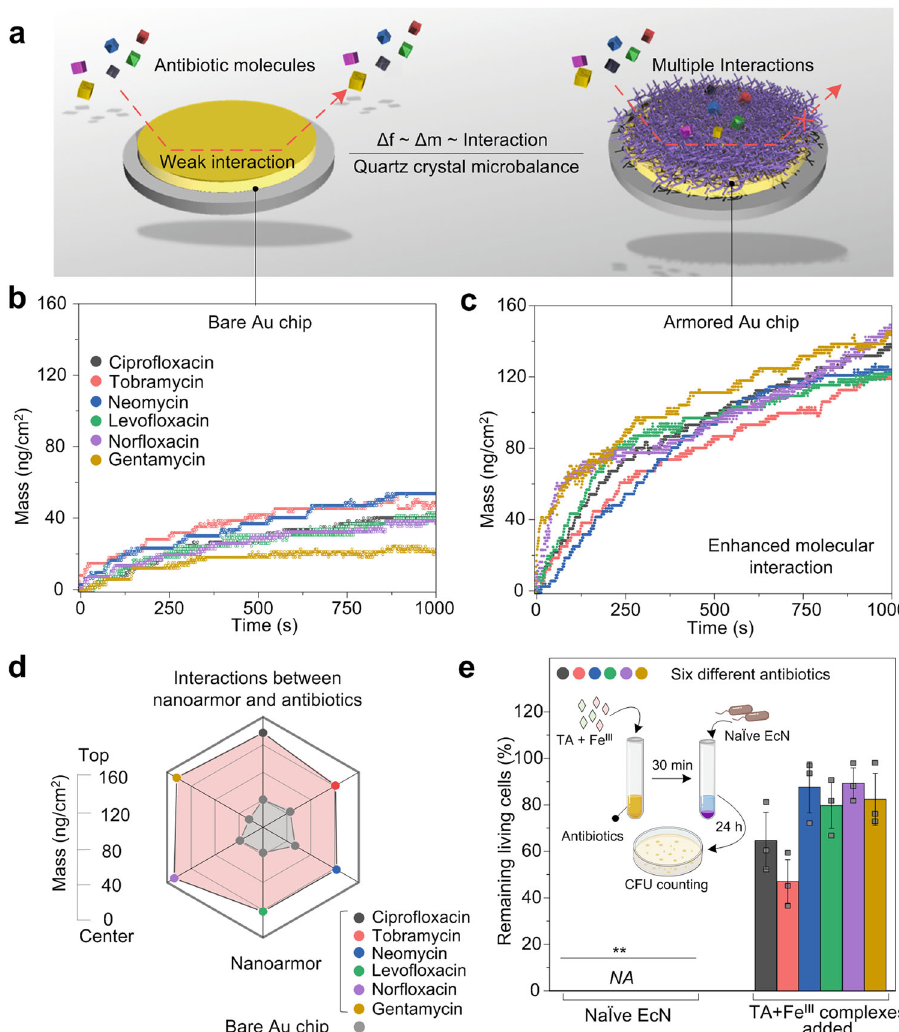
Fig. 3 Interaction between the cell nanoarmor and antibiotic molecules. a Schematic representation of the nanoarmor on QCM chips which enables enhanced mass adsorption due to the multiple interactions between polyphenol moieties and antibiotic molecules. The change of interfacial interactions can be detected by the frequency change, Δ f, which is proportional to the mass of the absorbed molecules, Δ m. b QCM analysis shows mass change over time as various antibiotics fl owed over a bare gold substrate or c a substrate armored with Fe III -TA. d Absorbed mass values on the bare and Fe III -TA functionalized substrates after equilibrium. e Cell viability of EcN incubated with either antibiotic at their respective MBCs ( NA not detectable) or with supernatants from each antibiotic premixed with Fe III -TA nanocomplex. Statistical comparisons were performed using two-tailed unpaired t -tests ( n = 3). For the group of cipro fl oxacin, p = 0.001713< 0.01. For the group of tobramycin, p = 0.002102 < 0.01. For the group of neomycin, p = 0.000354< 0.001. For the group of levo fl oxacin, p = 0.00033 < 0.001. For the grou p of nor fl oxacin, p = 0.000045< 0.001. For the group of gentamicin, p = 0.00048< 0.001. * p -value < 0.05; ** p -value < 0.01; *** p -value < 0.001. The graphs of Fig. 3e represent mean values ± standard error of mean. Signi fi cant differences between mean values were evaluated using ANOVA with multiple